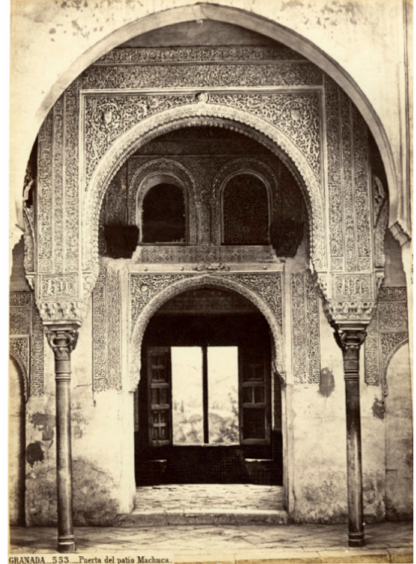
Figure 21. Portico and Cuarto Dorado before dismantling the 16th century arches. Photograph by Jean